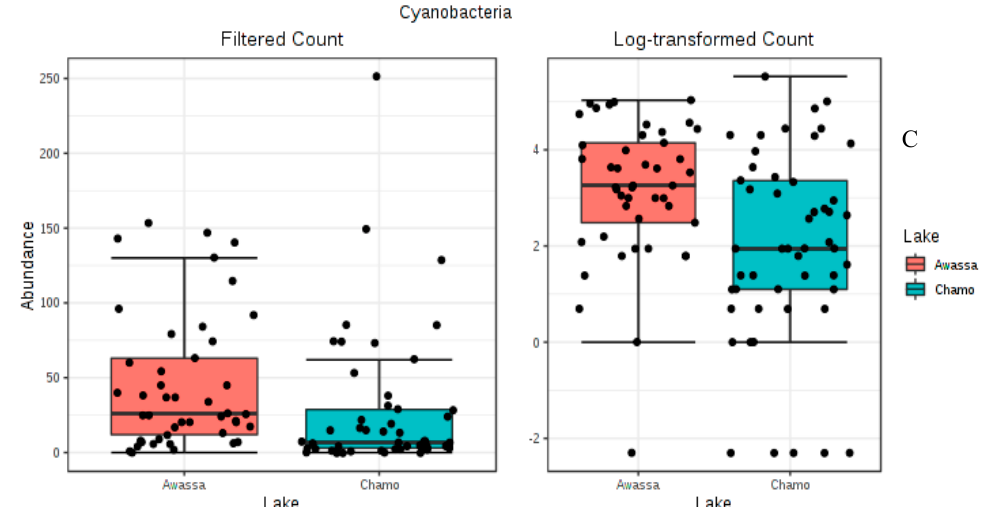
Figure 6. Figure 6. Differential abundance analysis done by a nonparametric test (Mann–Whitney/the Krus- kal–Wallis test) as it is implemented in MicrobiomeAnalyst [38]. ( A ) Differential abundance analysis of the Genus Ralstonia . ( B ) Differential abundance analysis of the Phylum Fusobacteria. ( C ) Differen- tial abundance analysis of the Phylum Cyanobacteria.